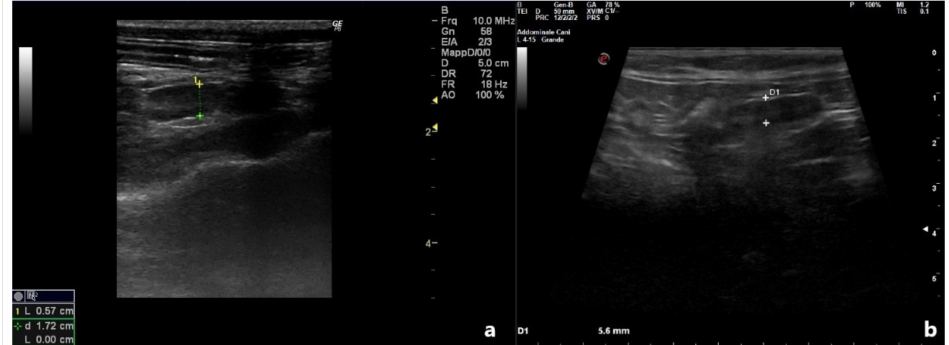
Figure 2. Ultrasonographic appearance of the same uterus reported in Image 1, 10 days after treatment. ( a ) Patient 2; ( b ) Patient 4.